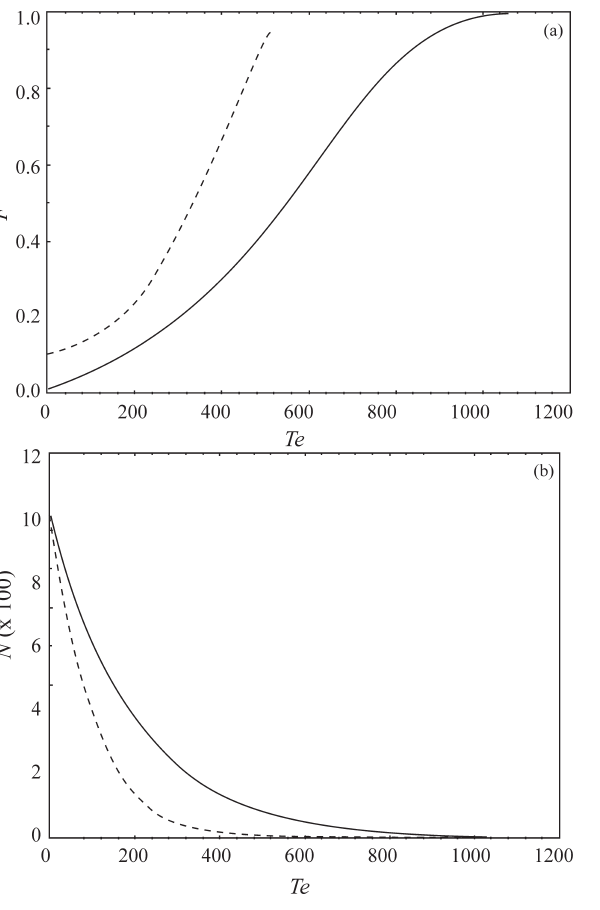
Figure 2 - Results of one simulation for the maned wolf population of the Parque Nacional das Emas. The variation in F -values (A) and in popula- tion size (B) through time in the two extreme scenarios are shown. The solid line shows the trajectory of the parameters in the best scenario and the dashed line indicates the trajectories in the worst